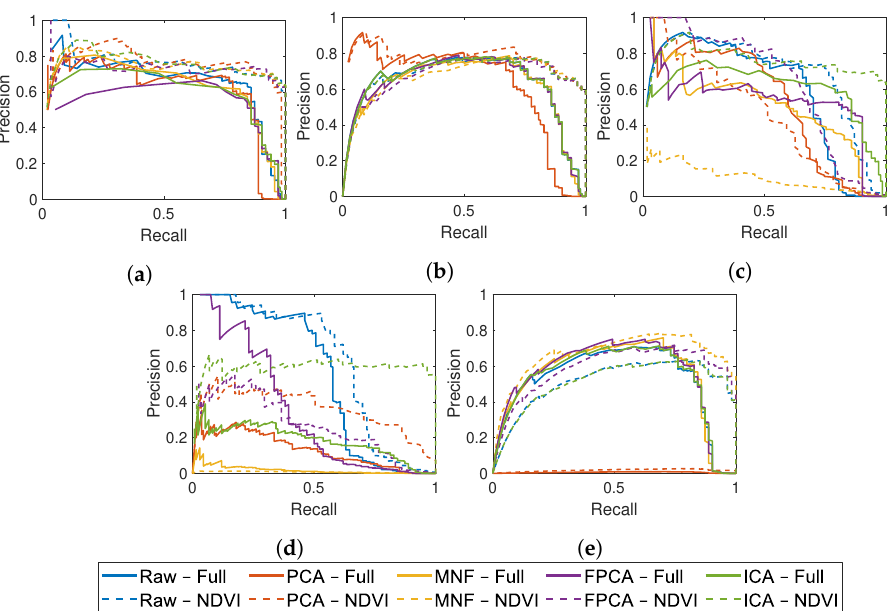
Figure 7. PR Curves for each TD and spectral DR scheme pairing in combination with spatial DR.